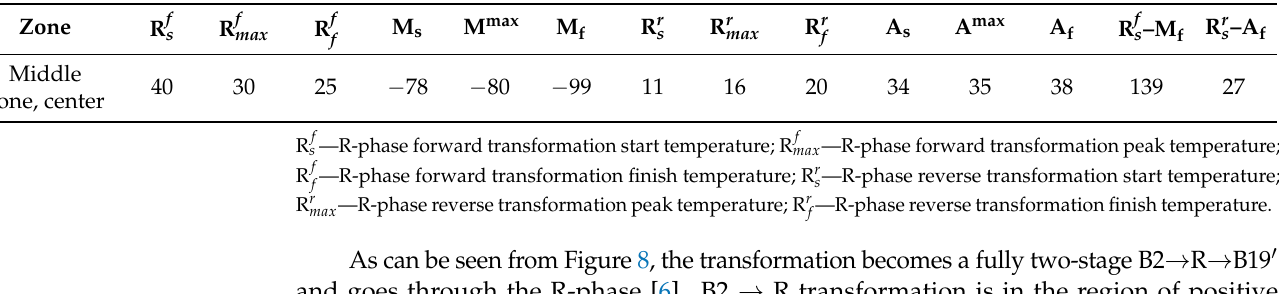
Table 2. DSC results from the middle zone of heat-treated specimen, ◦